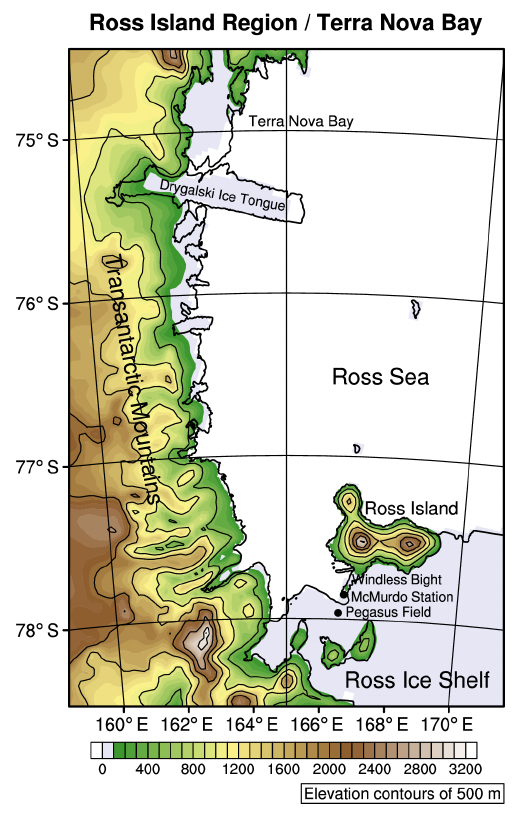
Figure 1. Geographic location map for the Ross Island and Terra Nova Bay